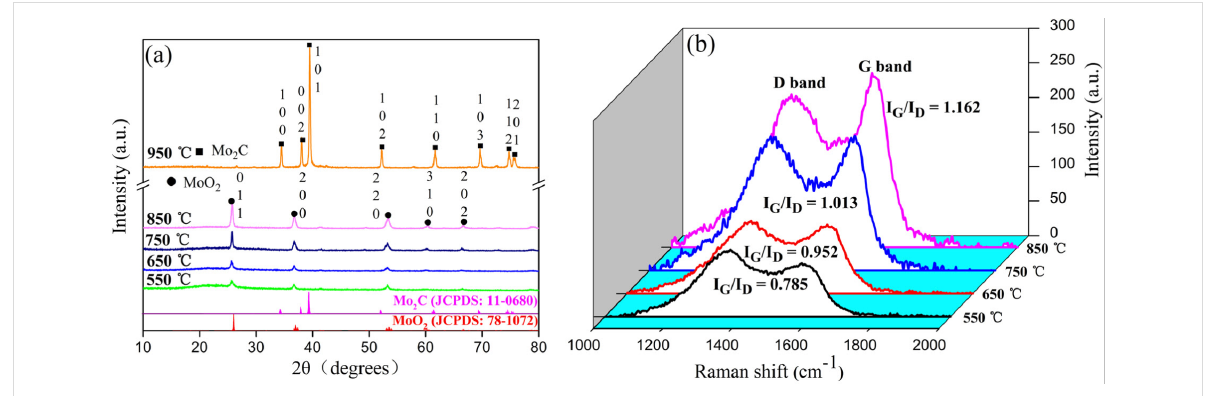
Figure 1: (a) XRD pattern and (b) Raman spectra of the MoO 2 –CNFs calcined at various temperatures.